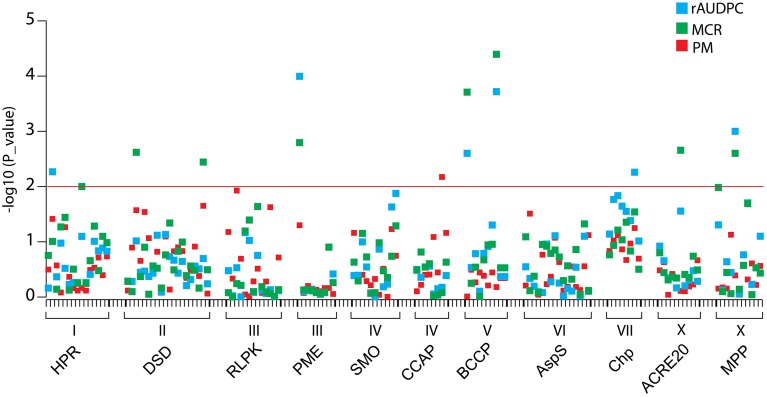
Association plot of SNPs at 11 candidate loci. SNPs are plotted on the x-axis and the –log10 of the p-values on the y-axis. The traits rAUDPC, MCR, and PM are shown by blue, green and red squares, respectively. The threshold p-value p = 0.01 is indicated by the horizontal line. Gene acronyms and chromosome positions are shown below the X-axis.